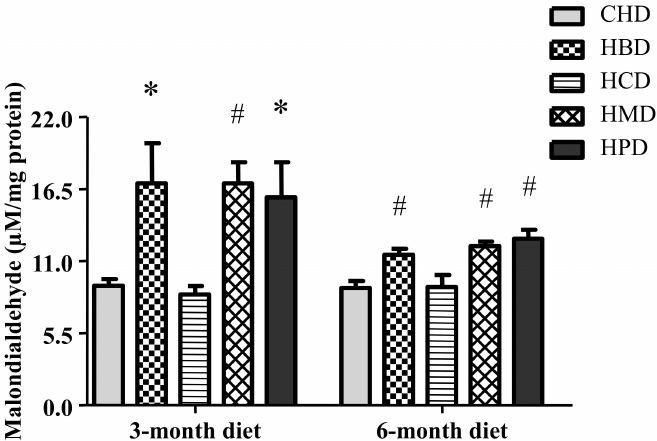
Figure 6. Malondialdehyde level in cardiac tissue of mice fed high-fat diets. Data are presented as mean ± standard deviation, n = 4–8. * p < 0.05 and # p < 0.01 versus